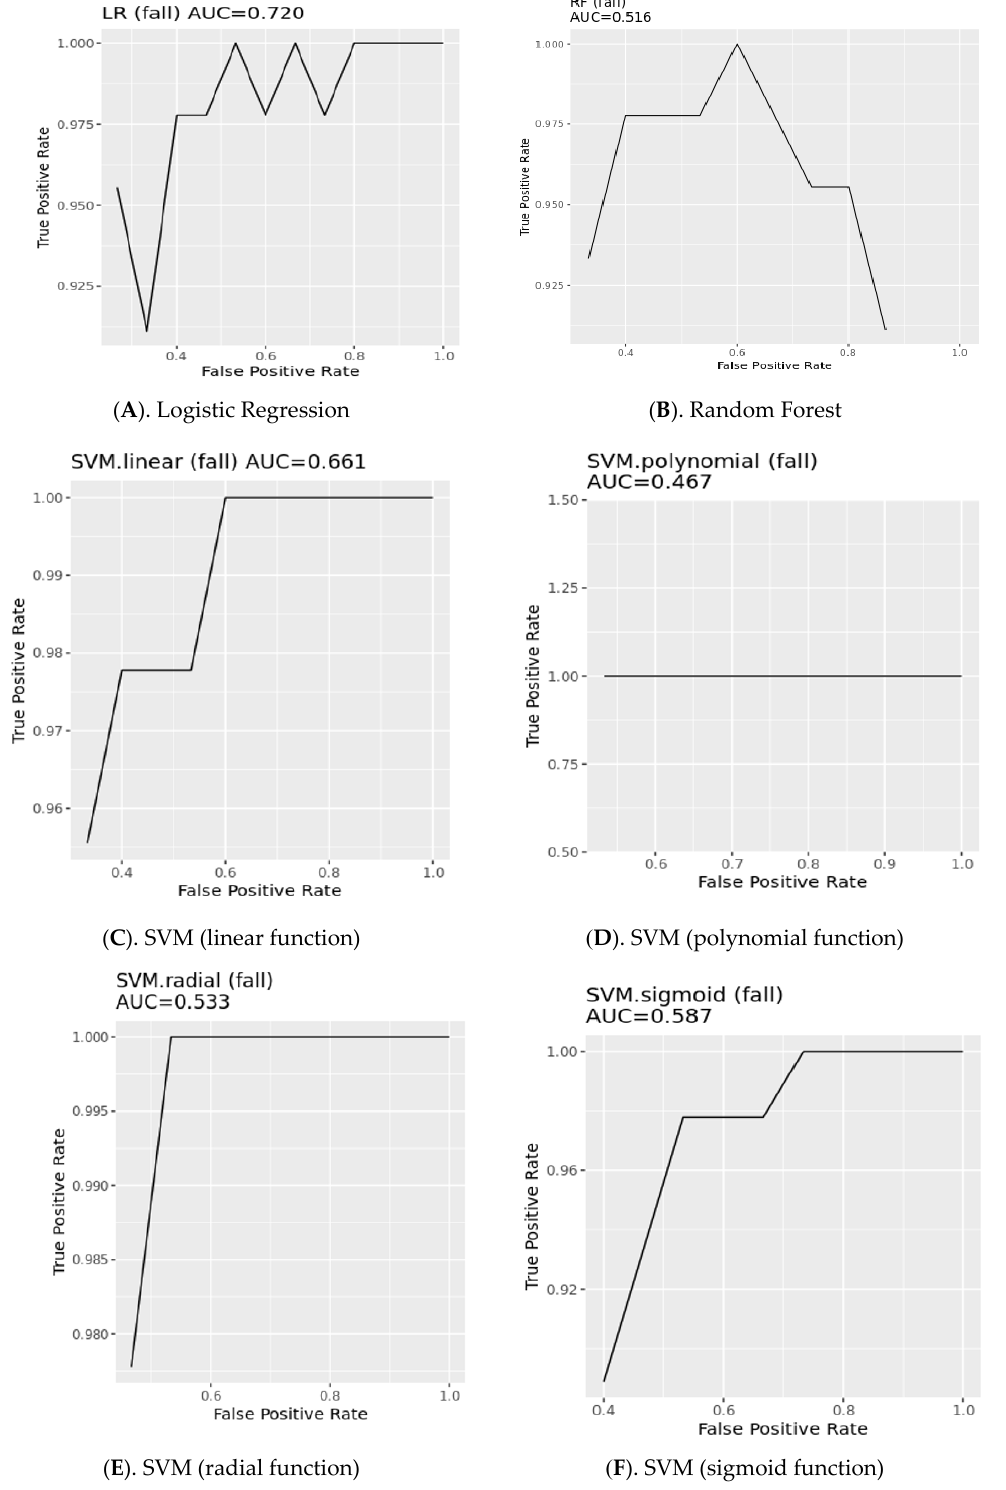
Figure 4. Area under the curve of prediction models.